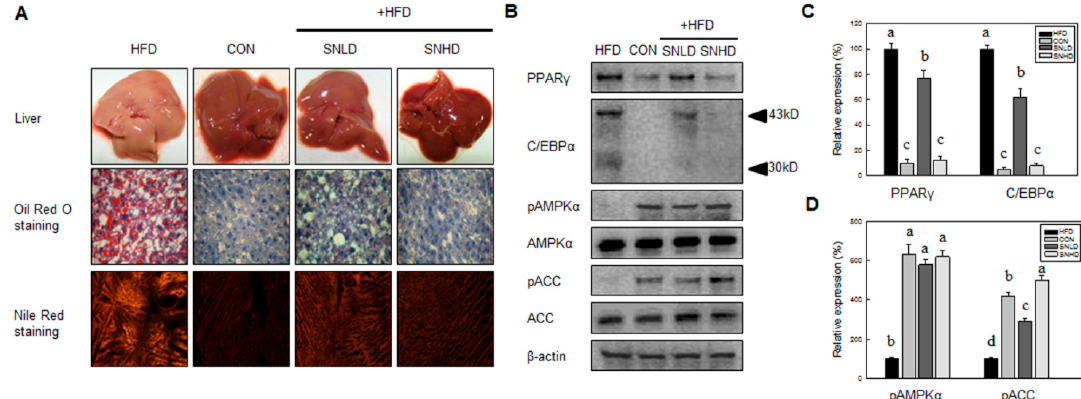
Figure 10. Effects of SN on the hisotophathological and proteomic analysis of hepatic tissue in high-fat-diet-induced obese mouse model. ( A ) Histopathological analysis of hepatic tissue; ( B ) Ptoteomic analysis of Body weight gain; ( C ) Total food intake; ( D ) Body weight gain normalized by food intake; ( E ) Western blot analysis of PPAR γ , C/EBP α , pAMPK α , AMPK α , pACC, ACC and β -actin in hepatic tissue. CON: normal diet, HFD: high fat diet, SN: seapolynol. Data are presented as means ± SD of eight mice. Means not designated by a common superscript are significantly different ( p < 0.05). Table 1. Mouse plasma lipid, glucose, and insulin levels.